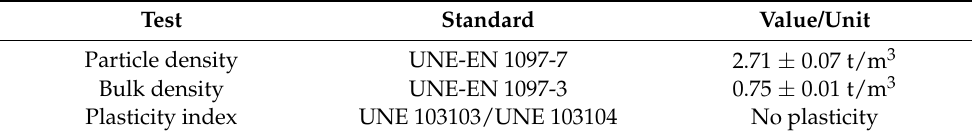
Table 6. Density and plasticity tests for the fine portion of ladle furnace slag.